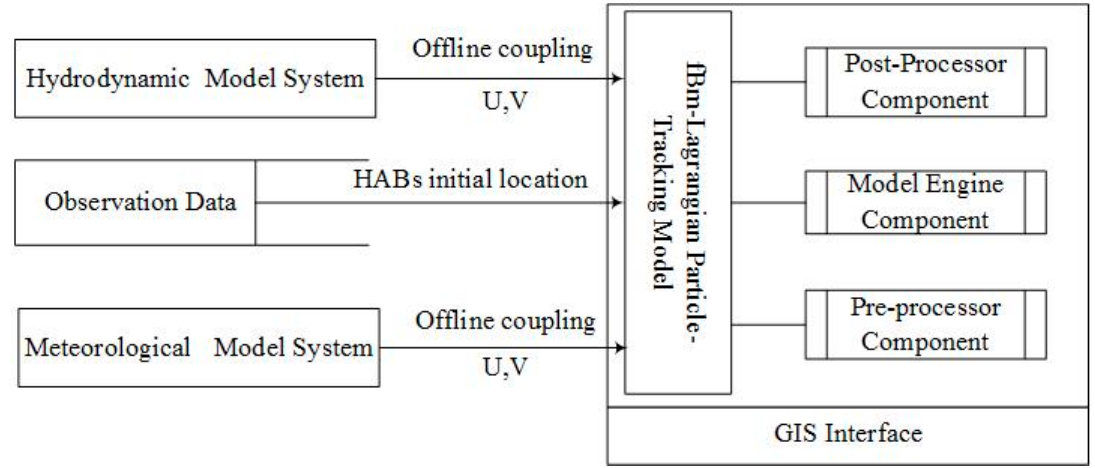
Figure 1. The schematic diagram of the general architecture of the GIS-based simulation tool. U and V are the pre-calculated velocities of winds or currents in x - and y -directions.